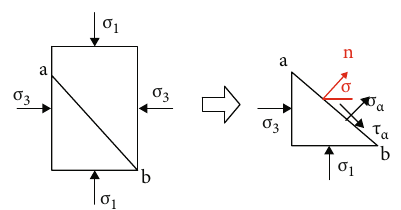
Figure 1: Stress state of fracture surface of fl